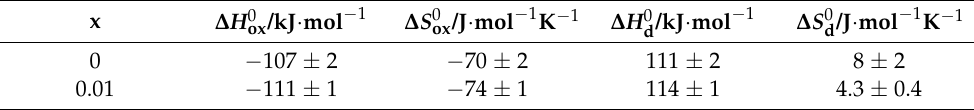
Table 3. Thermodynamic parameters of the defect formation reactions in La 0.5 − x Sr 0.5 FeO 3 − δ .